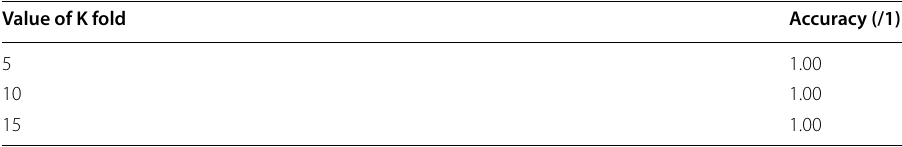
Table 8 Random Forest model accuracy result